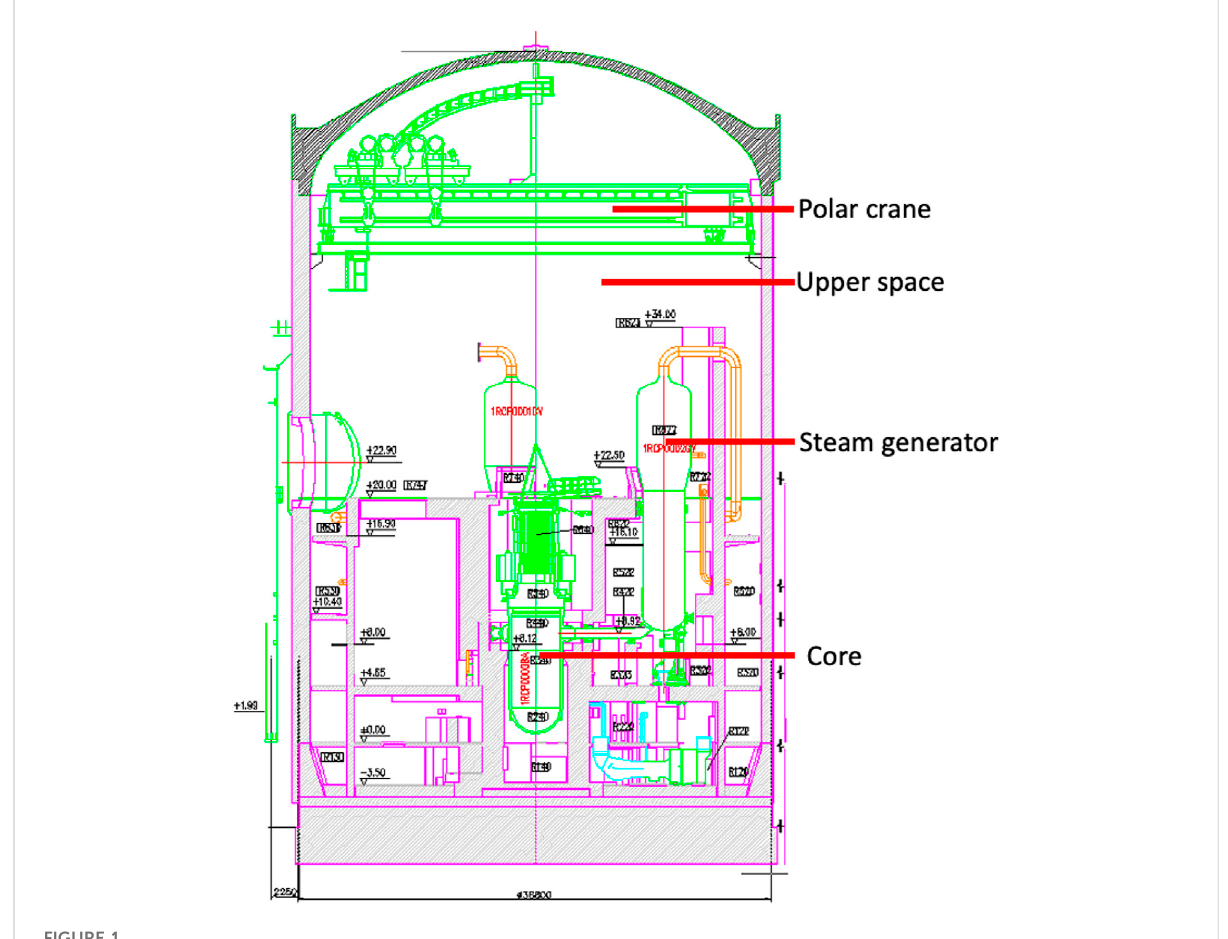
FIGURE 1 Daya Bay containment pro fi